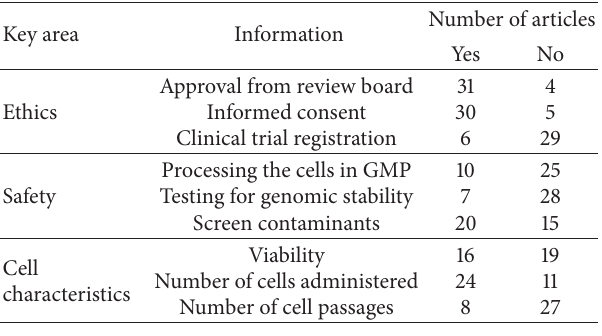
Figure 2: Disaggregated proportions of papers on human (+) and animal (++) application of ASCs that reported the use of expanded and unexpanded cells before and after IFATS/ISCT statement (before statement, human 𝑛 = 22 ; after statement, human 𝑛 = 13 ; before statement, animal 𝑛 = 47 ; after statement, animal 𝑛 = 34 ), percentage and 95% confidence interval, Fisher Exact Test 𝑃 < 0.001 with post hoc analysis, and ∗ significant difference 𝑃 < 0.01 .